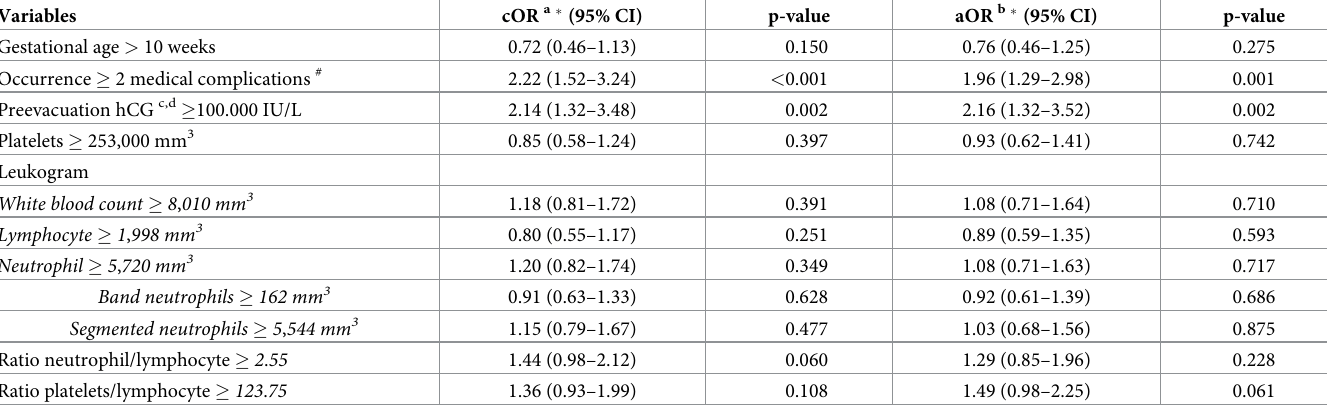
Table 4. Logistic regression for prognostic factors associated with development of gestational trophoblastic neoplasia after complete hydatidiform mole.